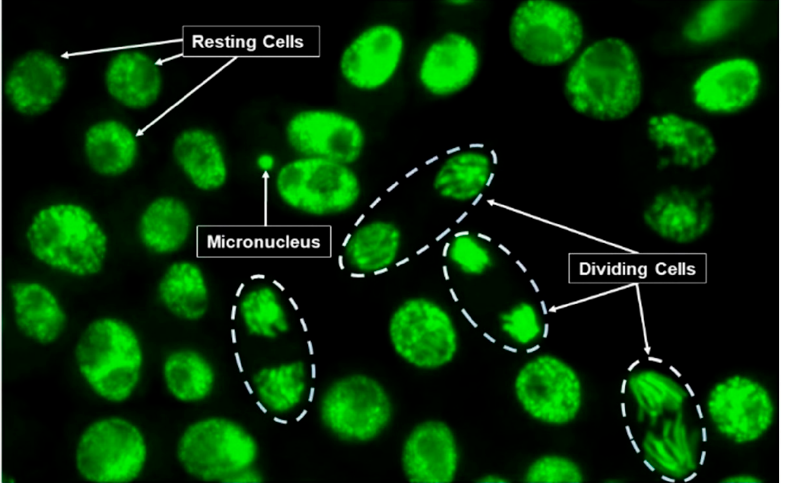
Figure 1. Picture of Micronuclei, dividing cells and resting cells observed in the root tips of Vicia faba stained with acridine orange, under a fluorescence microscope (400×). One slide with three root apices was prepared for each of five replicates. A total of 3000 cells per replicate were counted for analysis, accounting for a total of 15,000 cells scored for each condition. The percentage of mitotic cells, called mitotic index (MI), was calculated. Only roots with a MI greater than 20‰ were considered when scoring micro- nuclei in cells (AFNOR EN ISO 29200 (2020-05)) [38]. MN and MI were calculated as shown below: (cid:3014)(cid:3036)(cid:3030)(cid:3045)(cid:3042)(cid:3041)(cid:3048)(cid:3030)(cid:3039)(cid:3032)(cid:3036) (cid:3005)(cid:3036)(cid:3049)(cid:3036)(cid:3031)(cid:3036)(cid:3041)(cid:3034) (cid:3030)(cid:3032)(cid:3039)(cid:3039)(cid:3046) MN = × 1000 MI = × 1000 (cid:3019)(cid:3032)(cid:3046)(cid:3047)(cid:3036)(cid:3041)(cid:3034) (cid:3030)(cid:3032)(cid:3039)(cid:3039)(cid:3046) (cid:3021)(cid:3042)(cid:3047)(cid:3028)(cid:3039) (cid:3030)(cid:3032)(cid:3039)(cid:3039)(cid:3046) 2.8. Statistical Analysis As the data presented a normal distribution, one-way ANOVA and average compar- ison tests (Tukey) with a 95% confidence interval were performed using Sigma Plot 12.0. 3. Results and Discussion 3.1. Impacts of Biostimulants on Micronuclei Formation and Cell Division Frequency in Vicia Faba Roots Cells Fifty-six hours later, either exposure to the 4 commercial products, or to maleic hy- drazide as positive control (MH Control) or without treatment as the negative control (Control), micronuclei (MN) and diving cells (mitotic index MI) were scored in the root apices of Vicia faba , respectively (Figure 2A,B), and expressed as a ‰ of the total number of cells.